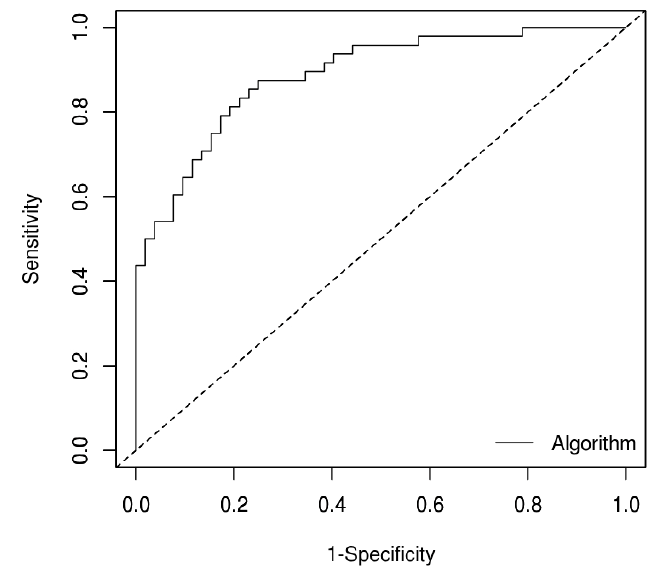
Figure 7. Receiver operating characteristic (ROC) curve analysis based on the algorithm described above: area under the curve (AUC) was calculated as 0.887.